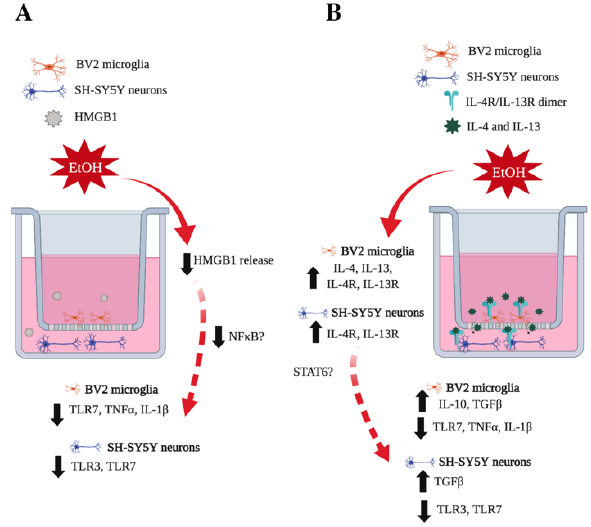
Figure 9. Ethanol increases IL-4 and IL-13 signaling between microglia and neurons. ( A ) Schematic illustrating a lack of HMGB1 release in co-cultured neurons and microglia that is correlated with a decrease in pro-inflammatory cytokine and receptors, possibly via altered NF κ B activity. ( B ) Schematic illustrating ethanol-induced IL-4 and IL-13 signaling between BV2 microglia and SH-SY5Y. Ethanol increases IL-4 and IL-13 in BV2 microglia, as well as IL-4R and IL-13R in SH-SY5Y. Downstream targets of IL-4 and IL-13, such as IL-10 and TGF β , are also increased in co-cultured cells and pro-inflammatory cytokines and receptors are decreased, possibly via a STAT6-mediated mechanism. Schematic made using Biorender (biorender.com).